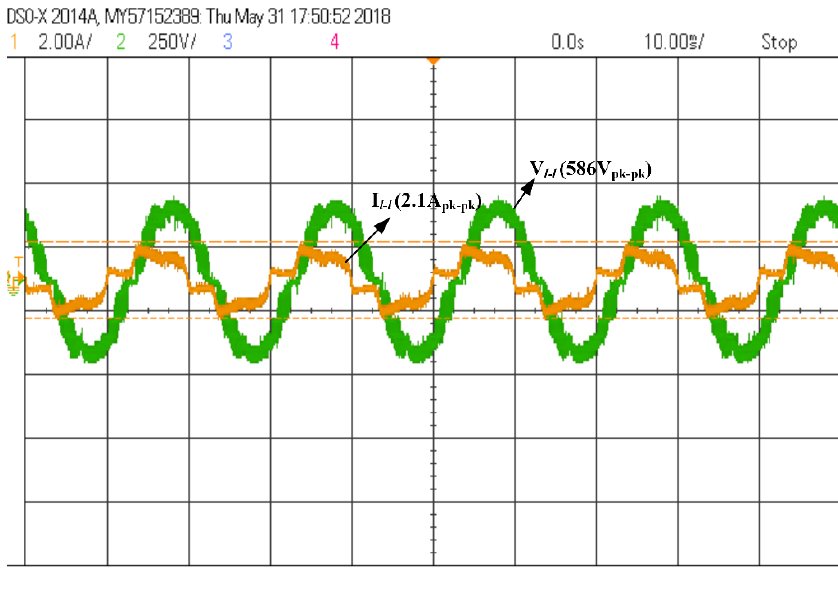
Figure 26. Output voltage and current of parallel inverter.